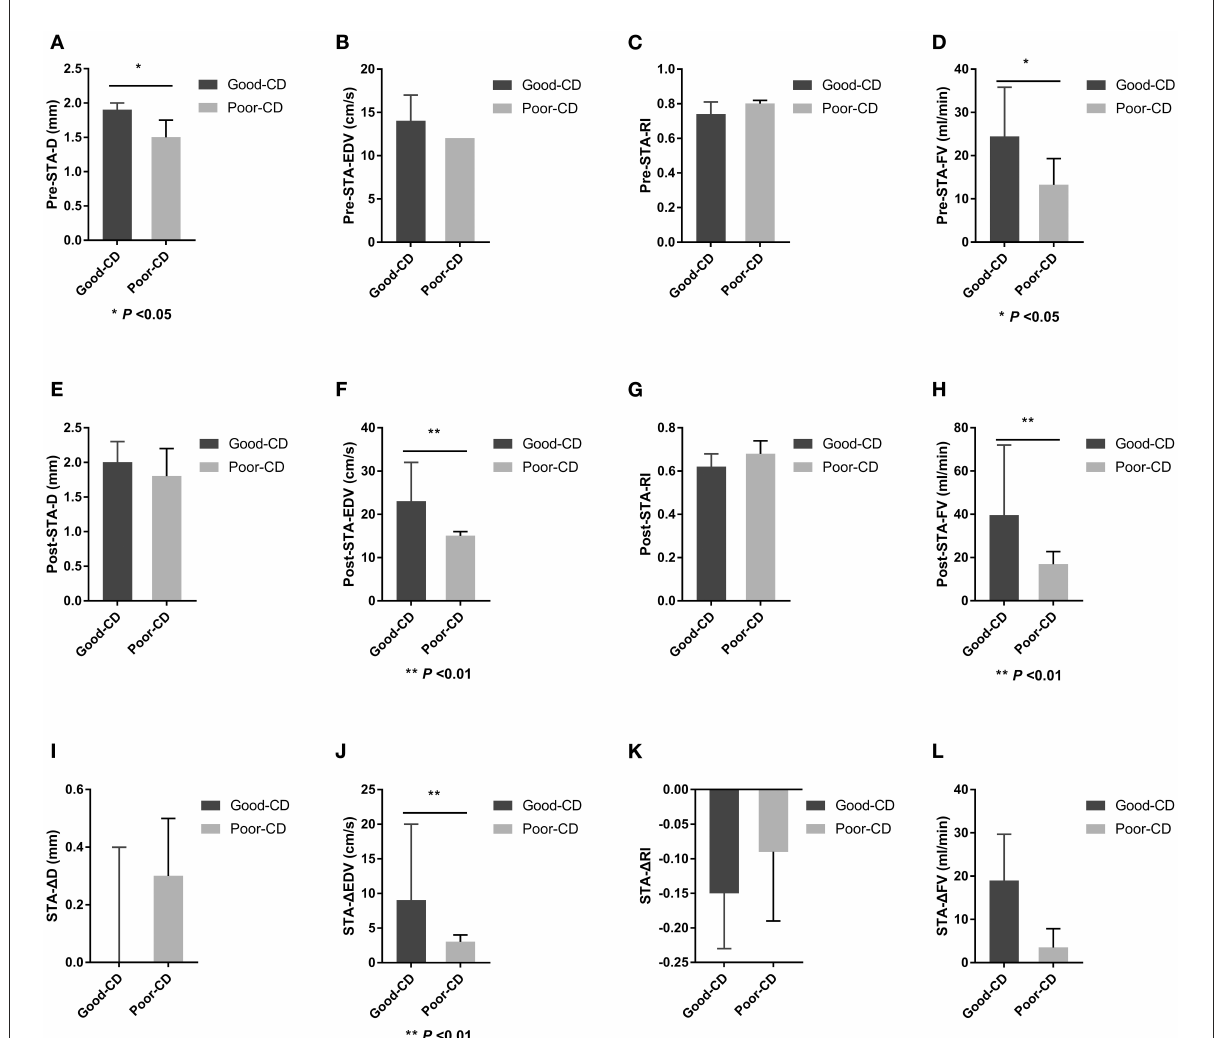
FIGURE5 Differences in STA ultrasound parameters between good and poor collateral development groups after STA-MCA anastomosis. STA, superficial temporal artery; MCA, middle cerebral artery; D, inner diameter; CD, collateral development; EDV, end-diastolic velocity; RI, resistance index; FV, flow volume; 1 , the difference between postoperative and preoperative